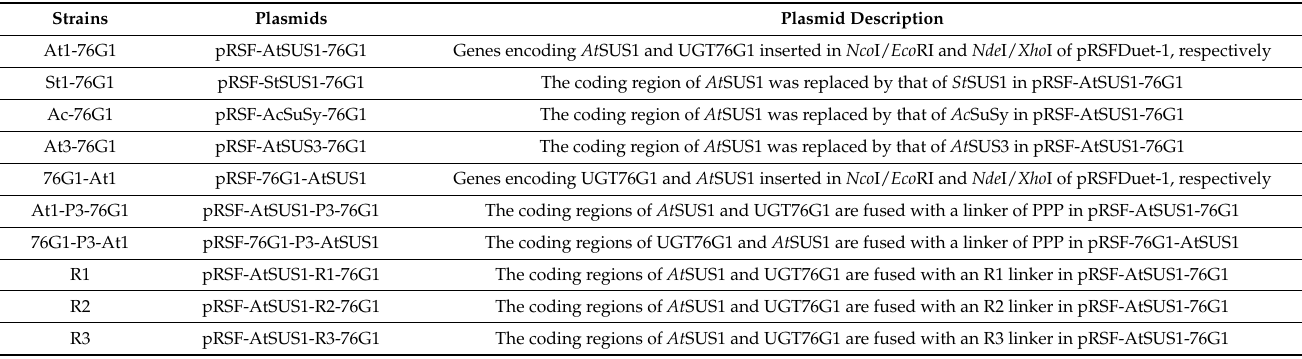
Table 1. Strains and plasmids used in this